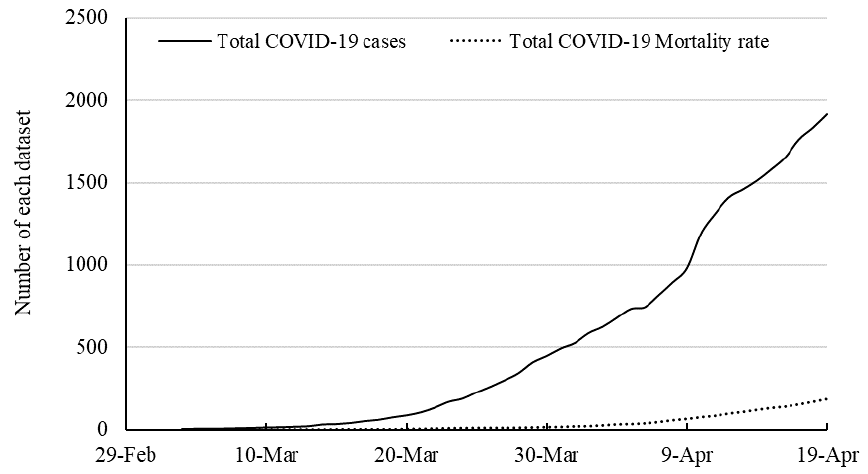
Figure 1. Total statistics for the number of cases and mortality rate of COVID-19.